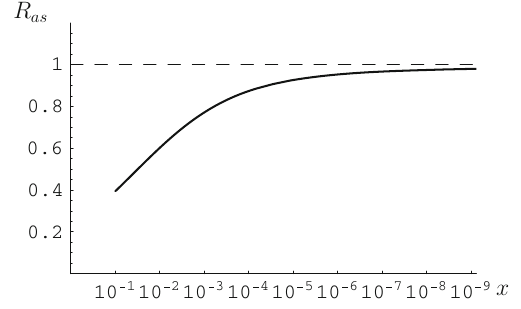
Fig. 3 Approach of A q to its asymptotics A as q at fixed Q 2 = 100 μ 2